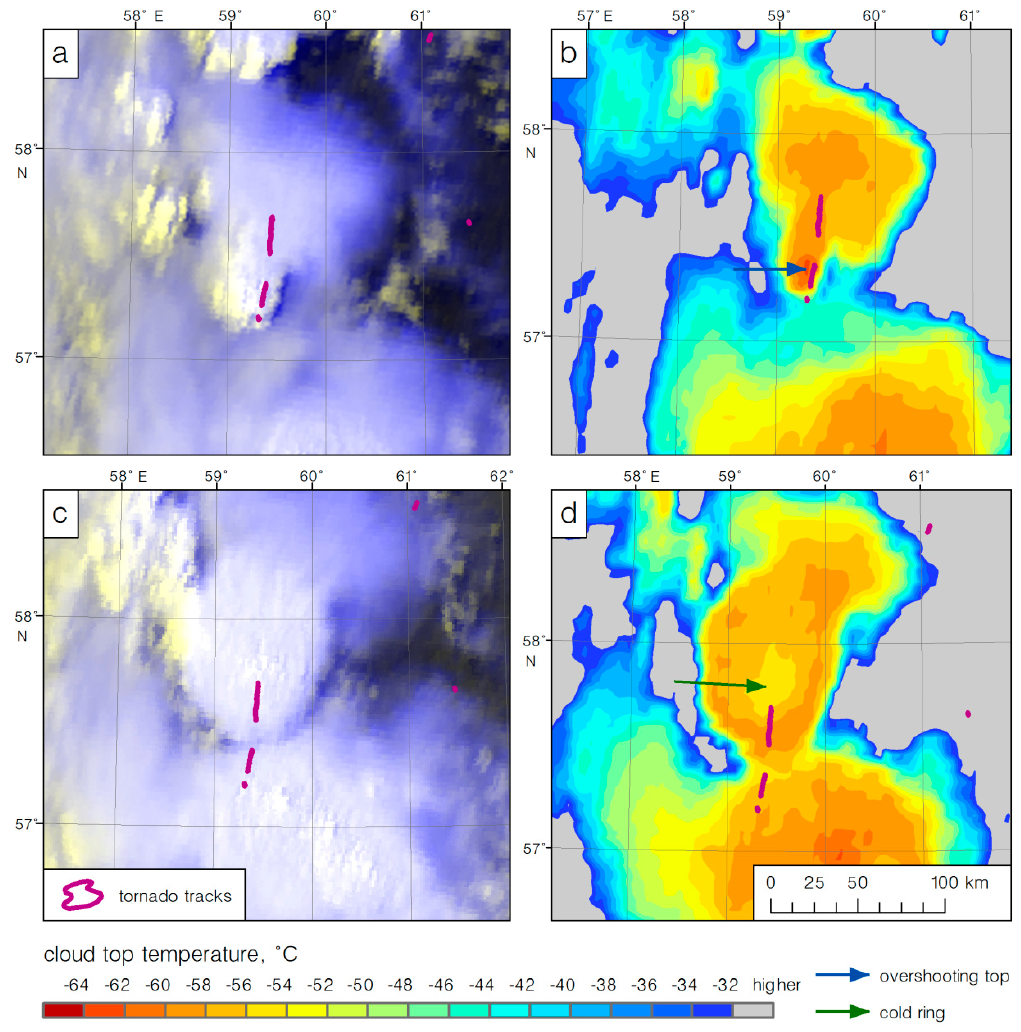
Figure 4. The severe convective storm over the west of the Sverdlovsk region on the Meteosat-8 images: HRV cloud RGB images and IR10.8 channel data (CTT < − 32 °C) at 1115 UTC ( a , b ) and 1145 UTC ( c , d ) of 3 June 2017. See also Supplementary Materials for animation.